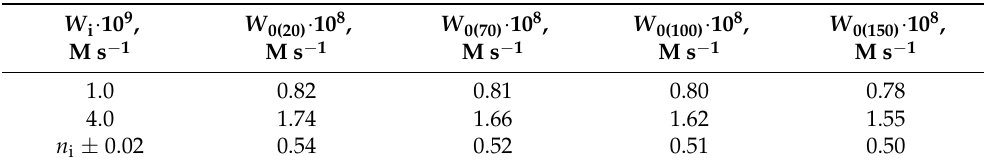
Table 5. Change in the order of initiated reaction of adrenaline oxidation ( n i ) with respect to W i over